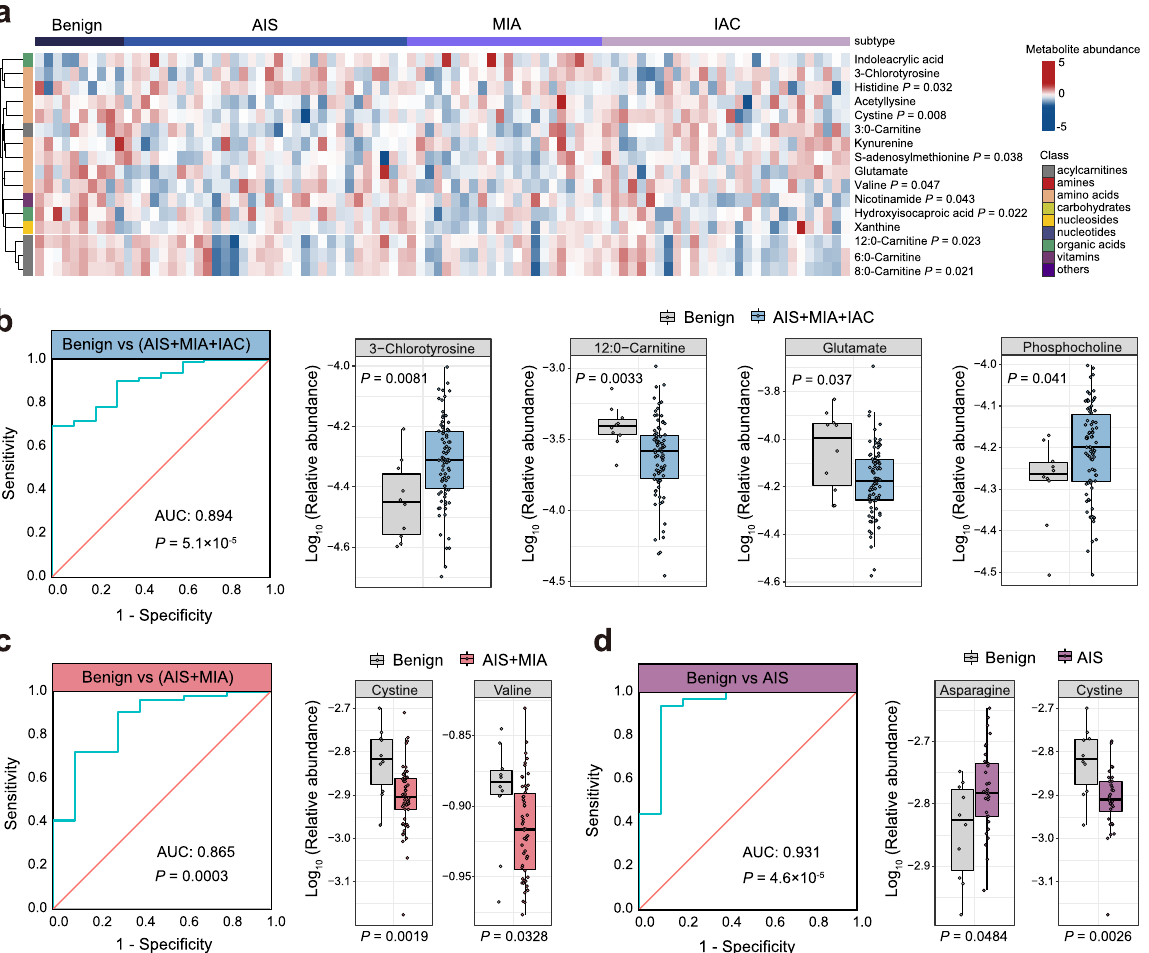
Fig. 3 The alteration of circulating metabolites in plasma from patients with different stages. a Heatmap of metabolite alterations from benign diseases, AIS, MIA, and IAC. Two-sided Kruskal-Wallis tests with P < 0.1. b The receiver operating characteristic (ROC) curve and log 10 relative abundance of 3- chlorotyrosine, 12:0-carnitine, glutamate, and phosphocholine (benign diseases, n = 10; AIS/MIA/IAC, n = 82). A two-sided Wilcoxon rank-sum test was used. c The ROC curve and log 10 relative abundance of cystine and valine (benign diseases, n = 10; AIS/MIA, n = 54). A two-sided Wilcoxon rank-sum test was used. d The ROC curve and log 10 relative abundance of asparagine and cystine (benign diseases, n = 10; AIS, n = 32). A two-sided Wilcoxon rank-sum test was used. In the box plots b – d, the center line represents the median, and the box bounds represents the inter-quartile range. The whiskers span 1.5- fold the inter-quartile range. AUC, Area Under